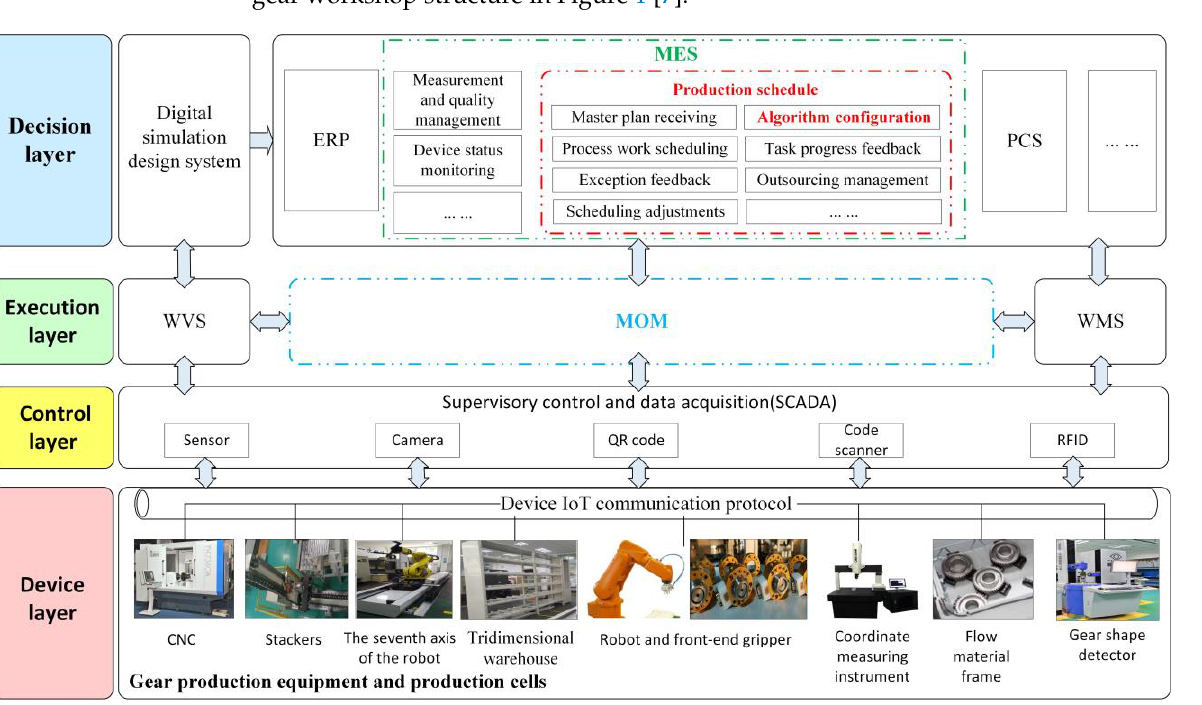
Figure 1. The model architecture of the smart gear workshop.